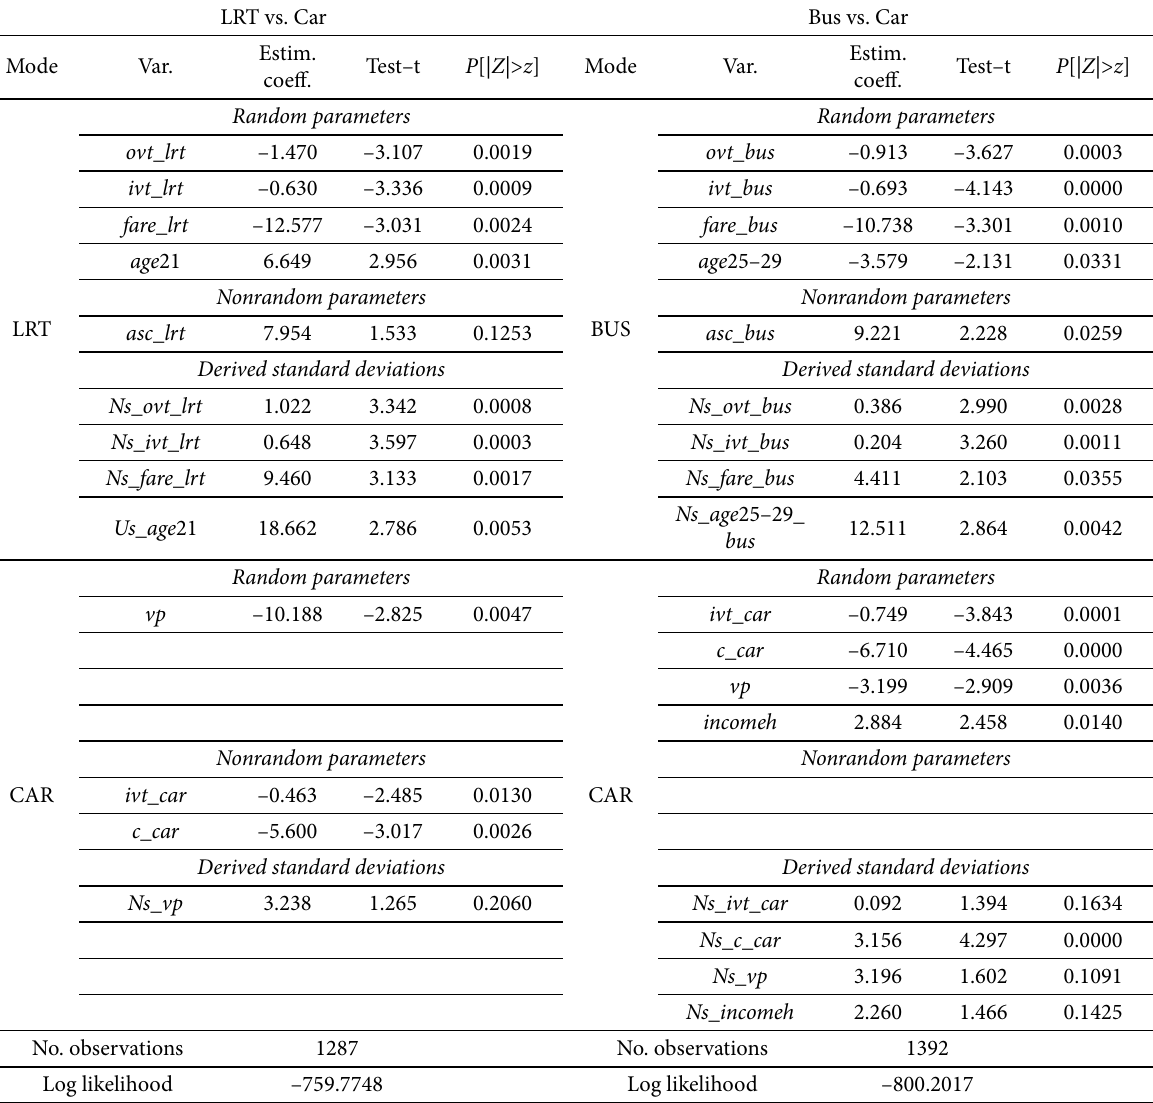
Table 6. Results of estimating ML model for LRT vs. Car and for Bus vs. Car LRT vs. Car Bus vs. Car